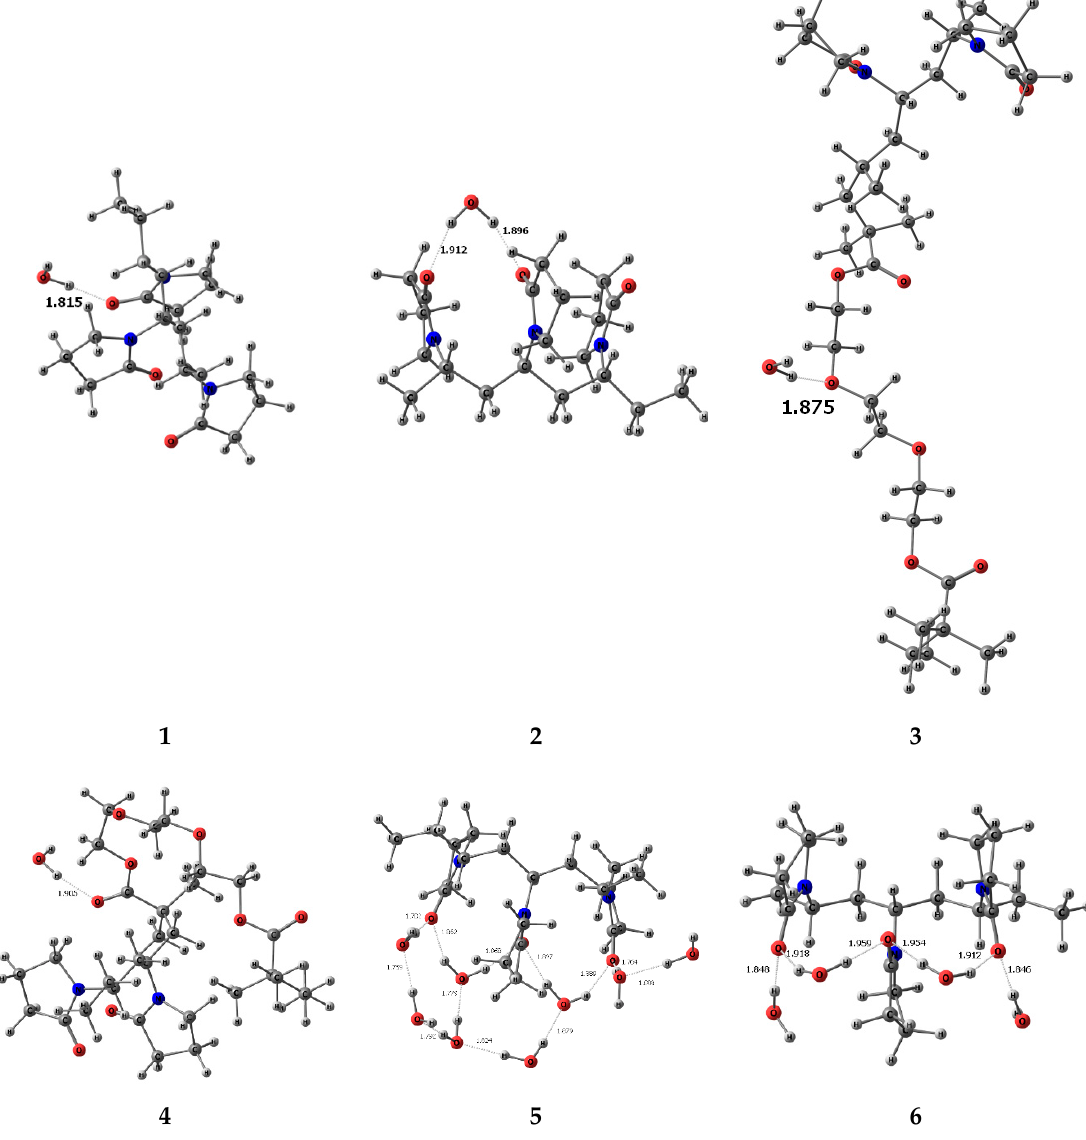
Figure 6. Optimized geometry of the VP-TEGDM sequences in the copolymer with water. The addition of two water molecules (i.e., the terminal and a bridge one) to the VP-VP-VP Table 2. Thermodynamic and energy parameters of the attachment of one water molecule to moiety (Figure 7) is accompanied by release of 10.5 k с al mol − 1 . Lengths and energies of the